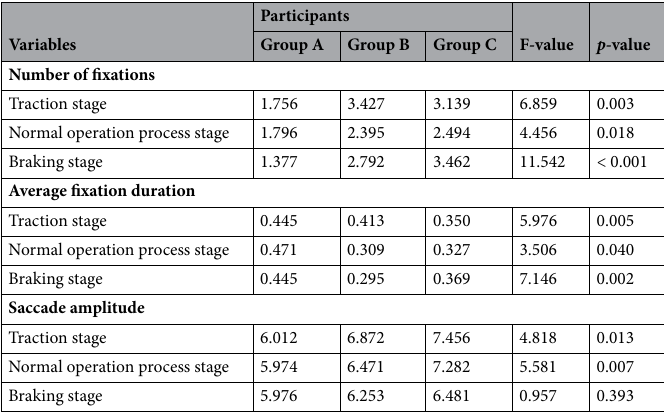
Table 2. Impact of driving experience on visual